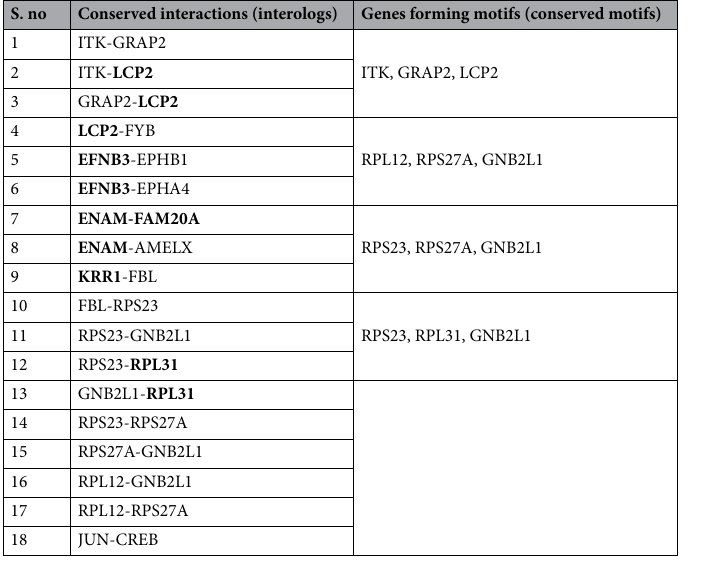
Table 6. Essential PPI interactions in TS